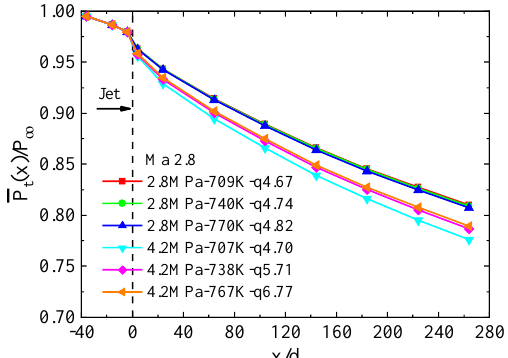
Figure 19. Total pressure recovery coefficient at different injecting conditions.